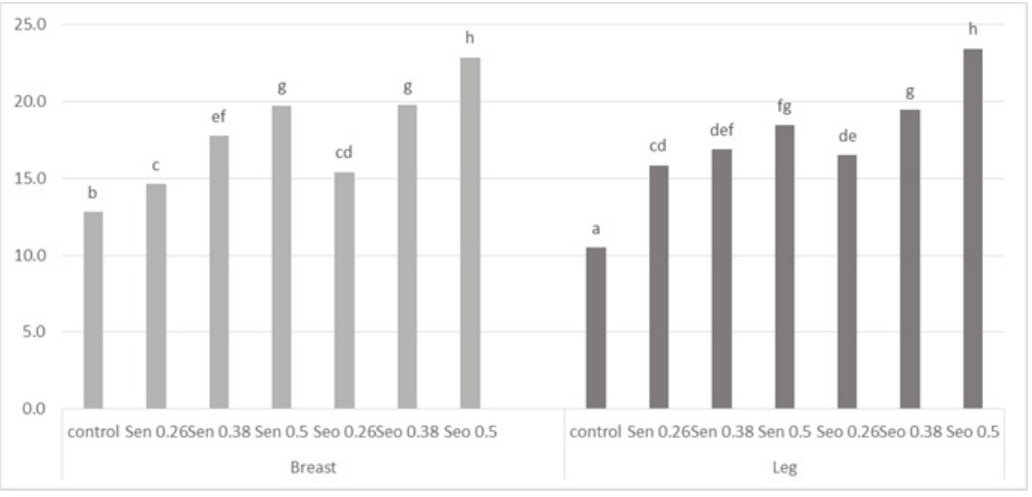
Figure 1: Selenium concentration in breast and leg muscles of chicken dietary modulated with organic and inorganic